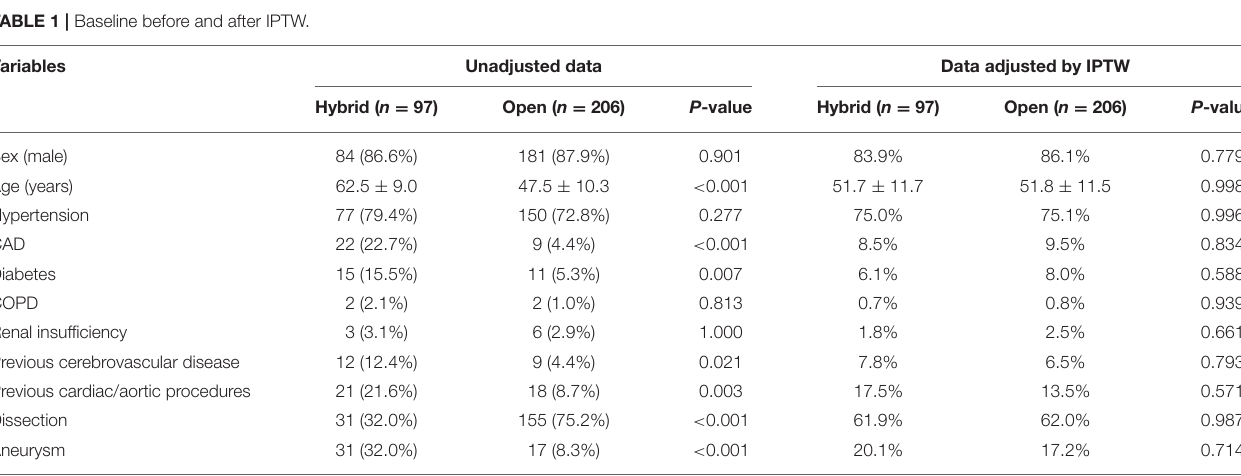
TABLE 1 | Baseline before and after